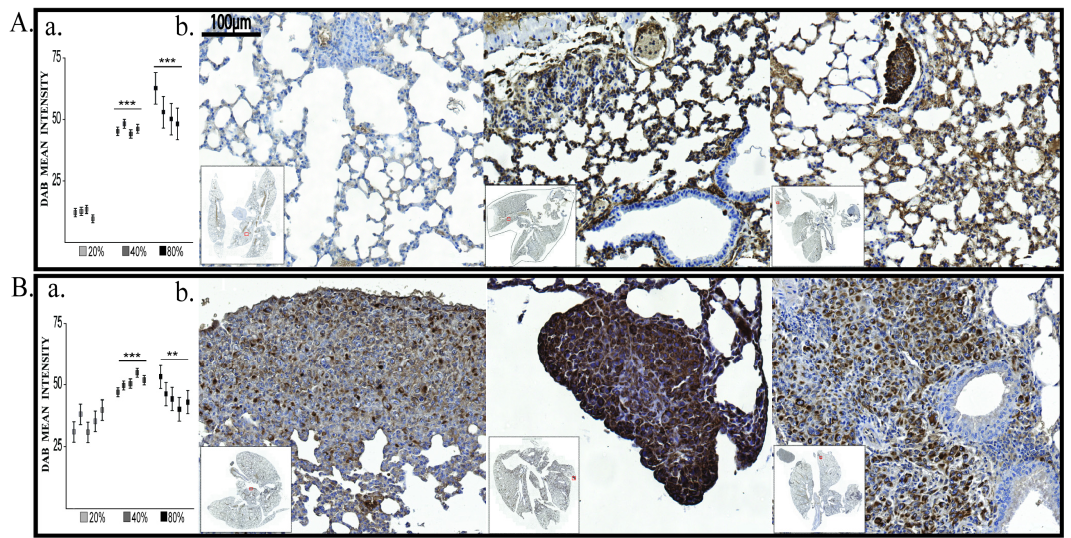
Figure 11. In vivo Vimentin protein expression. ( A ) At the end of oxygen exposure (T3) ( B ) At the end of experiment (T4); a. Protein quantification, each data point represent one mouse b. IHC pictures: left G1-21%, middle G2-40%, right G3-80%; Immunofluorescence pictures: ** p < 0.005, *** p < 0.0005.